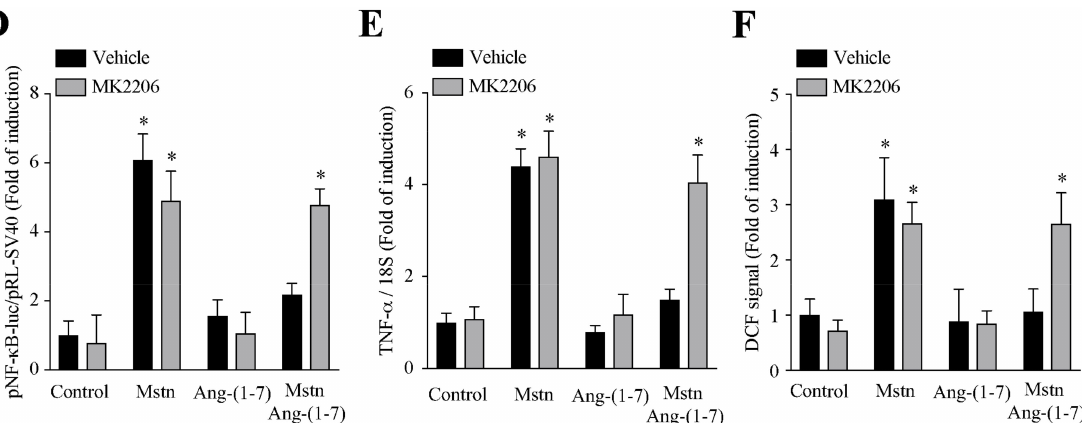
Figure 7. Prevention of myostatin-dependent muscle atrophy and signaling by Ang-(1-7) is mediated by the Akt / PKB activity in the myotubes. The C 2 C 12 myotubes were incubated with myostatin (Mstn, 1 µ g / mL) for 12 or 24 h in the presence or absence of Ang-(1-7) (10 nM), MK2206 (10 µ M; pre-incubated for 30 min), or both. The parameters measured were as follows: ( A ) distribution of the myotube diameters; mRNA levels of ( B ) atrogin-1, ( C ) MuRF-1 and ( E ) TNF- α ; ( D ) Luciferase activity of pNF- κ B-luc; and ( F ) ROS levels. The values are expressed as a fold of induction relative to the myotubes without treatment, and correspond to the mean ± SD from three independent experiments ( n = 3; * p < 0.05 vs. control without